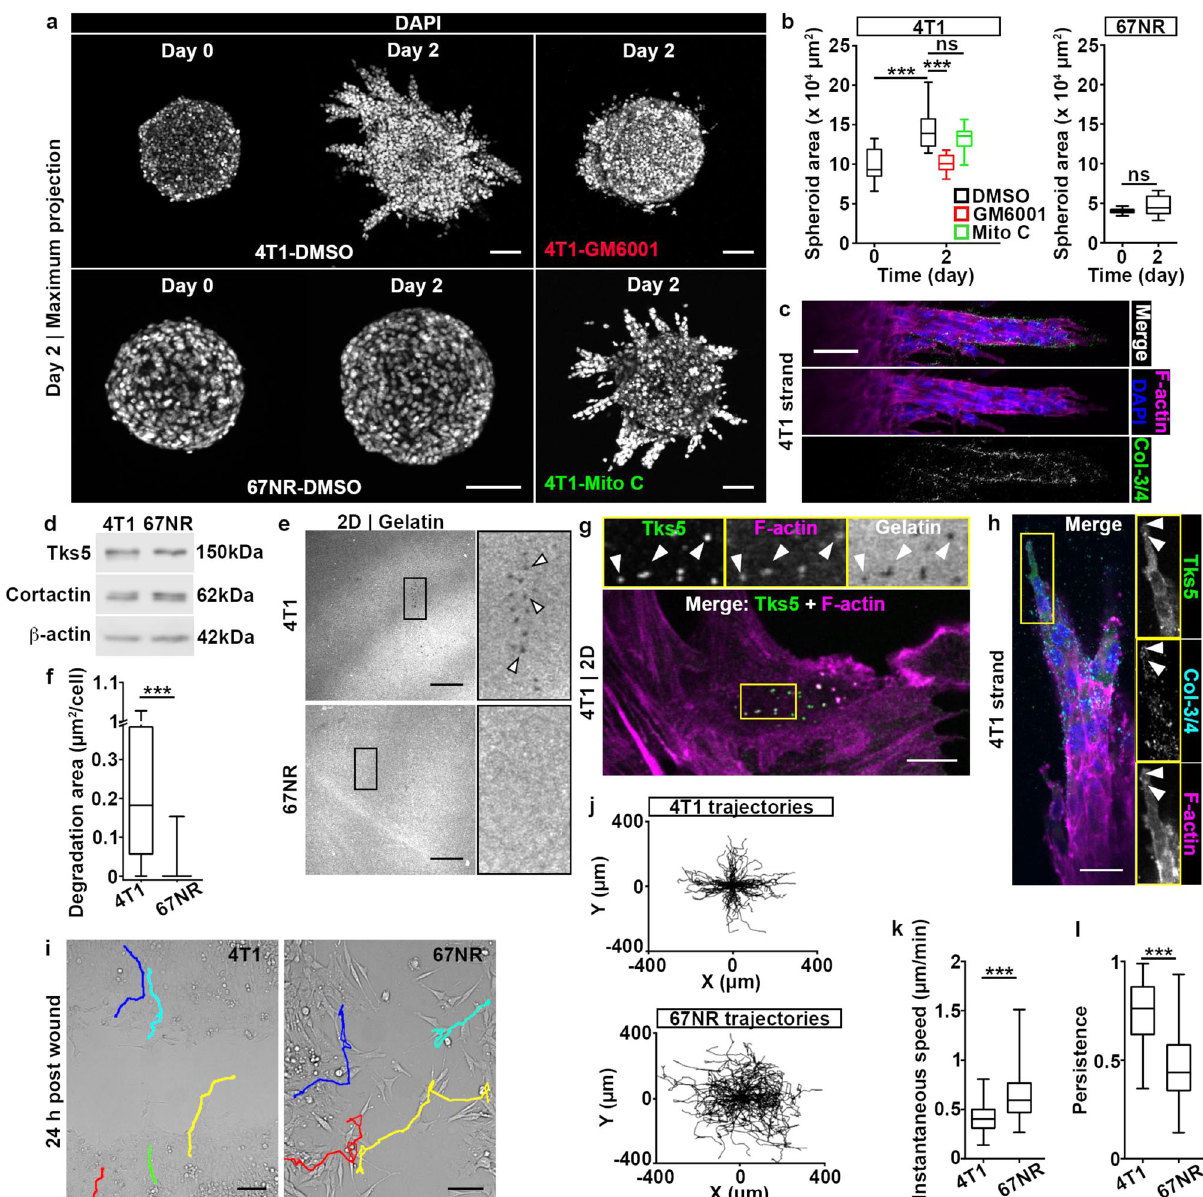
Fig. 1 4T1 cells, but not 67NR cells, exhibit MMP-dependent spheroid invasion. a Spheroids of 4T1 and 67NR cells at day 0 and day 2 post-embedding in a 3D collagen I matrix. Nuclei were stained with DAPI. Spheroids were treated from day 0 with a pan-MMP inhibitor (GM6001, top right panel), a cell cycle inhibitor (mitomycin C, Mito C, bottom right panel) or DMSO control (left panels). Scale bars: 100 µ m. b Spheroid area as a function of time for 4T1 and 67NR cells from ( a ). P = 5.81×10 − 4 and 1.23×10 − 4 , by the t -test. c Invading strand of a 4T1 spheroid, day 2 post-embedding, immunolabeled for MMP-cleaved collagen I (Col-3/4, green) and stained for F-actin (phalloidin, magenta) and nuclei (DAPI, blue). Scale bar: 50 µ m. d Western blot of Tks5 and cortactin expression in 4T1 and 67NR cells. β -actin is used as a loading control. e Gelatin degradation for 4T1 (top panel) and 67NR (bottom panel) cells 18h post-plating. The insets show a 4X zoom-in of the boxed area and arrowheads indicate representative degradation holes. Scale bars: 20 µ m. See Fig. S3a for F-actin. f Degradation areafor 4T1and 67NR cellsfrom ( e ). P <4.40×10 − 16 , by the Wilcoxon rank sum test. g 4T1 cellsculturedon fl uorescent gelatin (gray),labeledfor Tks5 (green) and F-actin (phalloidin, magenta). The insets show a 2X zoom-in of the boxed area and arrowheads indicate representative functional invadopodia. Scale bar: 10 µ m. h 4T1 strand on day 2 days post-embedding, labeled for Tks5 (green), cleaved collagen (cyan), F-actin (magenta) and nuclei (blue). The insets show a 1.25X zoom-in of the boxed area. Scale bar: 30 µ m. i 4T1 (left) and 67NR (right) monolayers 24h post-wounding. Representative cell trajectories are shown. See Movie S1. Scale bars: 100 µ m. j Trajectories of 4T1 (top) and 67NR (bottom) cells from the wound assay in ( i ), shown as wind-rose plots shifted to a common origin. k Instantaneous speed of 4T1 and 67NR cells from ( j ). P = 1.17×10 − 13 , by the Wilcoxon rank sum test. l Persistence (net displacement/path length) of 4T1 and 67NR cells from ( j ). P <2.20×10 − 16 , by the Wilcoxon rank sum test. Uncropped western blots are available in Supplementary Fig. S13. 67NR and 4T1 cells sorted from each other starting on day 3. them at a 1:50 ratio, to account for the higher proliferation rate of Individual optical slices (Movie S2) and the analysis of cell coor- 4T1 over the course of the spheroid invasion assay (Fig. S4a, b). We dinates clearly demonstrated the enrichment of 4T1 cells at the next embedded the mixed spheroids in collagen I, and performed edge of spheroids (Figs. 2b and S4d). To quantify cell sorting, we daily longitudinal imaging (Figs. 2a and S4c) 33 . We noticed that COMMUNICATIONS BIOLOGY| (2022) 5:758